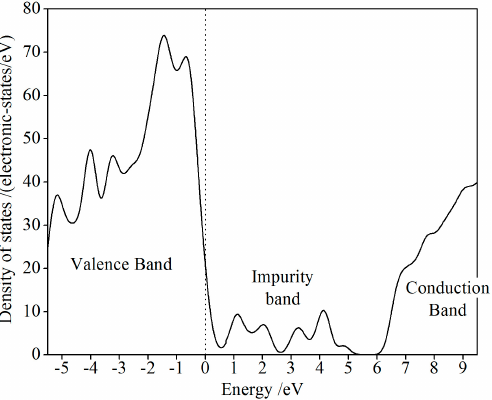
Figure 8. Density of state for oil system with unsaturated carbonized-fragments.